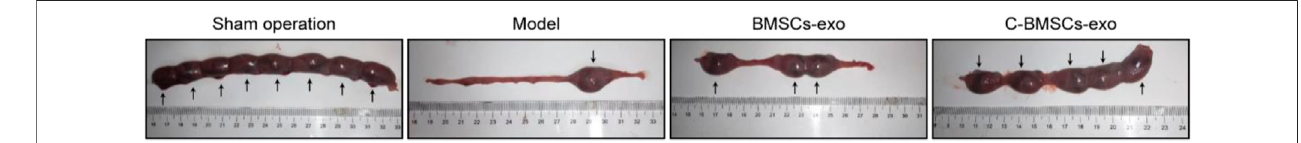
Frontiers in Bioengineering and Biotechnology |